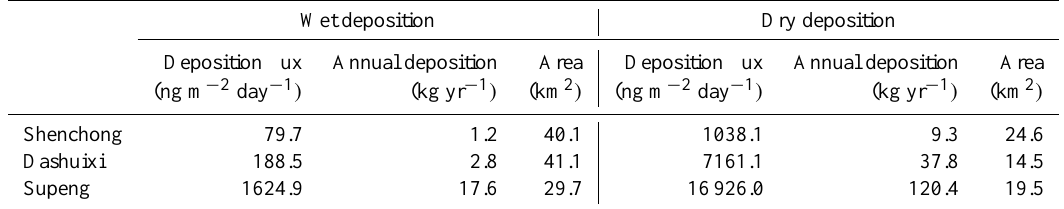
Table 2. Estimated THg deposition fluxes and annual THg deposition at Supeng, Dashuixi and Shenchong sites of